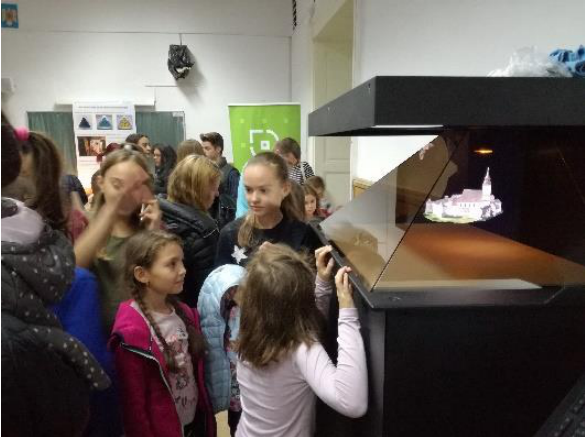
Figure 4. Researchers’ Night participants looking at the holographic